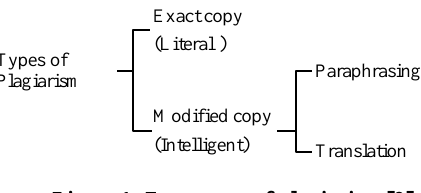
Figure 1: Taxonomy of plagiarism [6].